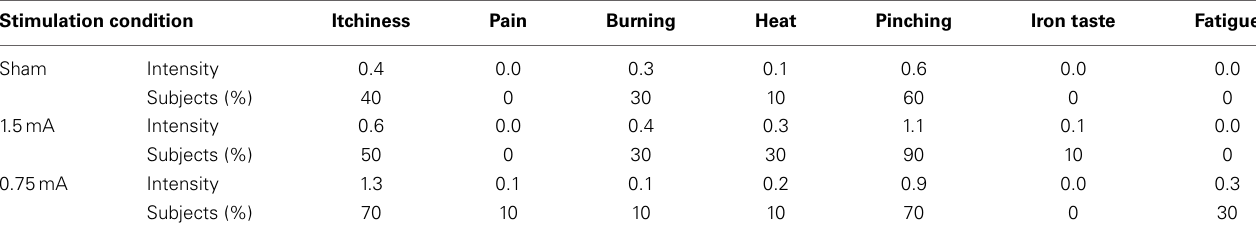
Table 2 | Transcranial direct current stimulation (tDCS)-induced sensations—Experiment 3 (See Table 1 description). Stimulation